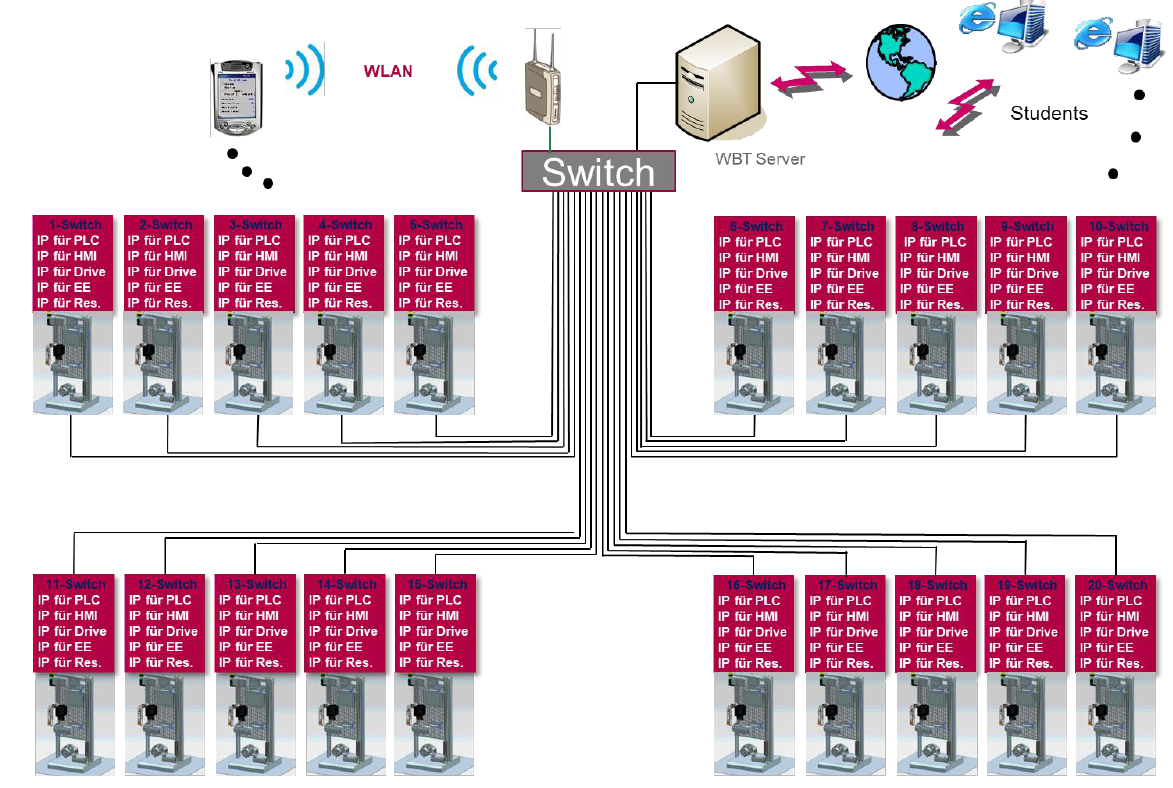
Figure 4. IoT architecture for practical